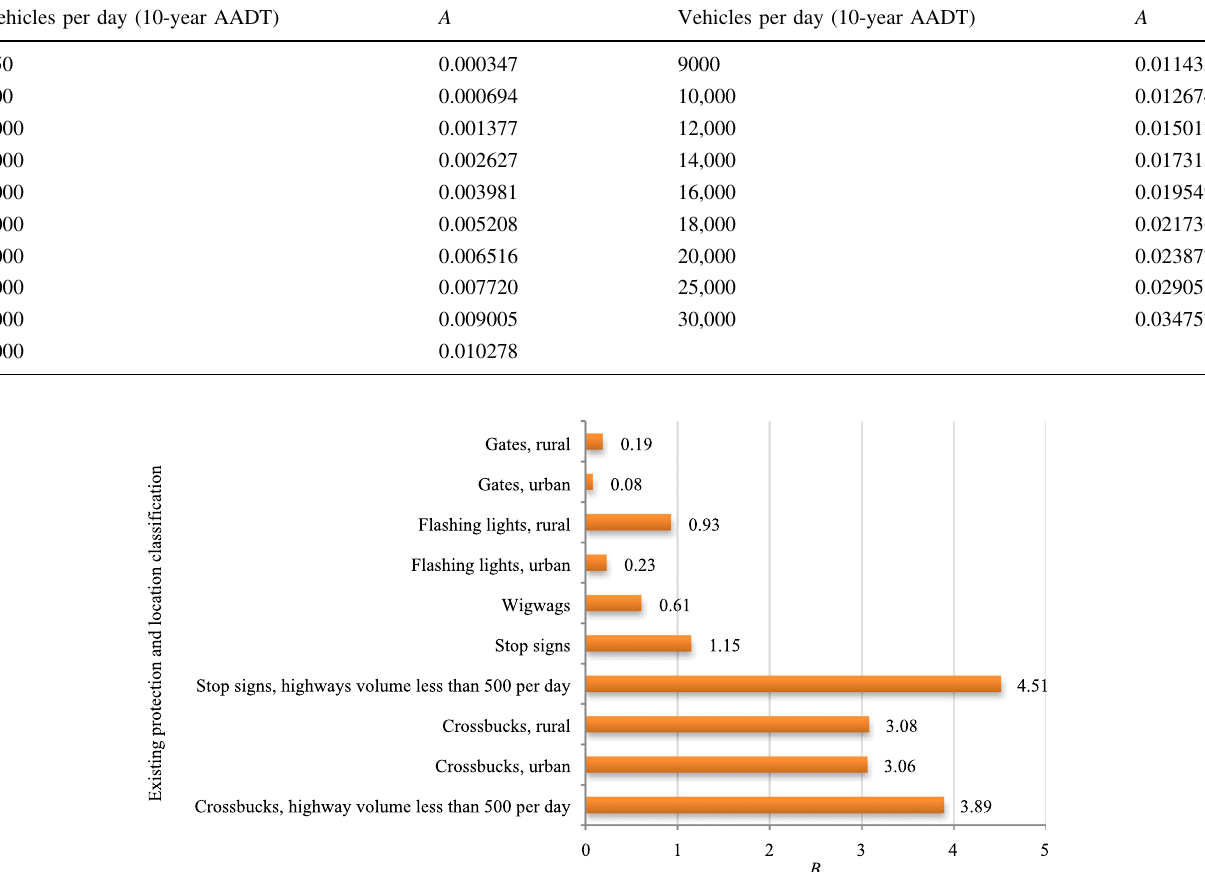
Fig. 3 B values based on the existing protection and location